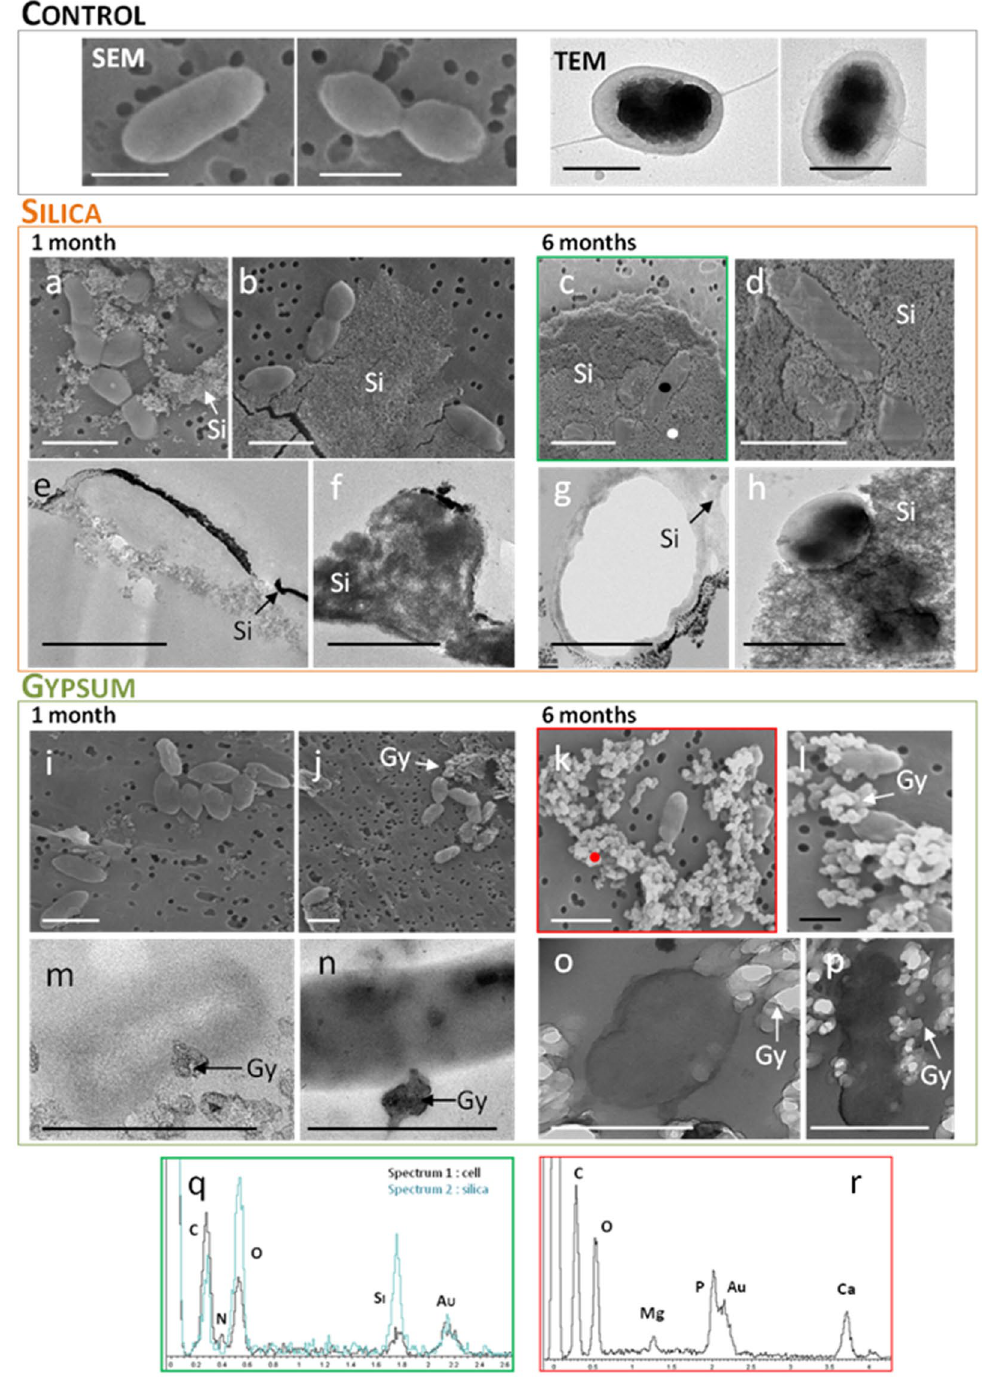
Figure 1. SEM and TEM images of non-mineralized Yersinia cells (upper panel in black) and after mineralization, either in silica (medium panel in orange) or in gypsum (lower panel in green). ( a , b ) SEM after 1 month, ( c , d ) 6 months and ( e , f ) TEM after 1 month, ( g , h ) 6 months in silica. ( I , j ) SEM after 1 month, ( k , l ) 6 months and ( m , n ) TEM after 1 month, ( o , p ) 6 months in gypsum. Scale bar: 1 µ m. The occurrences of silica (Si) and gypsum with other sulfate compounds (Gy) is indicated. The EDX spectra of image C ( q ) is framed in green and the location of EDX analyses is indicated by black and white dots for cells and silica respectively. The EDX spectra of image K ( r ) is framed in red and location of analyze in indicated by the red